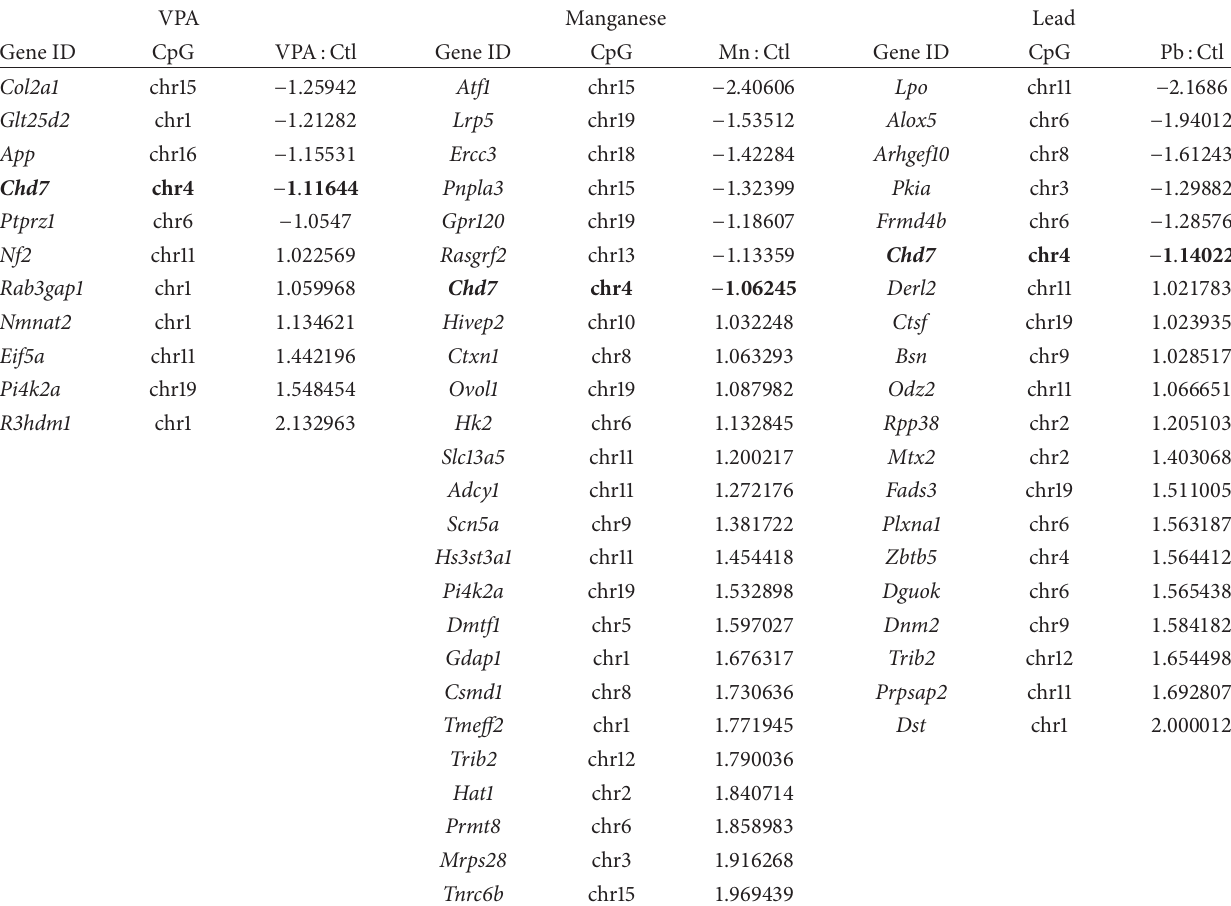
Table 3: Differentially methylated regions and associated